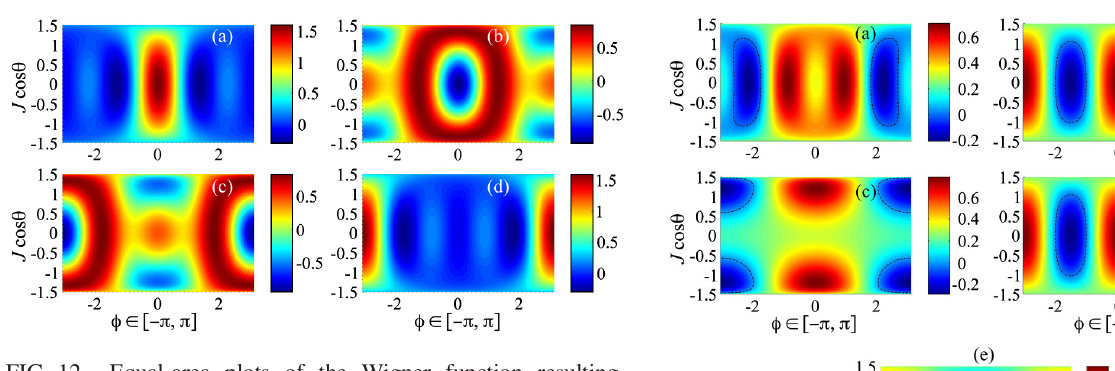
FIG. 12. Equal-area plots of the Wigner function resulting unbiased basis from transforming four different states to the M 1 ¼ diag ð 1 ; 0 ; 0 ; 0 Þ , (b) (cid:1) ¼ ( D ¼ 4 ). (a) The transform of (cid:1) 0 0 ¼ diag ð 0 ; 0 ; 1 ; 0 Þ , and (d) (cid:1) ¼ diag ð 0 ; 0 ; 0 ; 1 Þ . diag ð 0 ; 1 ; 0 ; 0 Þ , (c) (cid:1) 0 0 Unlike the unbiased basis generated by the QFT, not all of the resulting states are like the Pegg-Barnett phase states; see, for example, (b) and FIG. 13. A Wigner function comparison between the QFT (top row) and MUB transform (bottom row) for D ¼ 4 . We plot an equal mixture of two eigenstates with the optimal permutation [(a) and (c)] and a poor permutation [(b) and (d)] for each transform. In (a) through (d), the dashed black line is the zero contour. (a) The optimally permuted state for the QFT (cid:1) ¼ diag ð 1 ; 1 ; 0 ; 0 Þ = 2 . (b) The worst permutation for the QFT (cid:1) ¼ diag ð 1 ; 0 ; 1 ; 0 Þ = 2 . (c) The optimally permuted state for the MUB transform (cid:1) ¼ diag ð 1 ; 1 ; 0 ; 0 Þ = 2 . (d) Apoor permutation for the MUB transform (cid:1) ¼ diag ð 1 ; 0 ; 0 ; 1 Þ = 2 . Note that cases (b) and (d) are actually identical. Unlike the QFT case, the mixture of optimally permuted MUB states has two peaks which could be distinguished by a measurement of J z . (e) The worst permutation, i.e., (cid:1) ¼ diag ð 1 ; 0 ; 1 ; 0 Þ = 2 , after the transform to unbiased basis, which results in no purification. the M 1